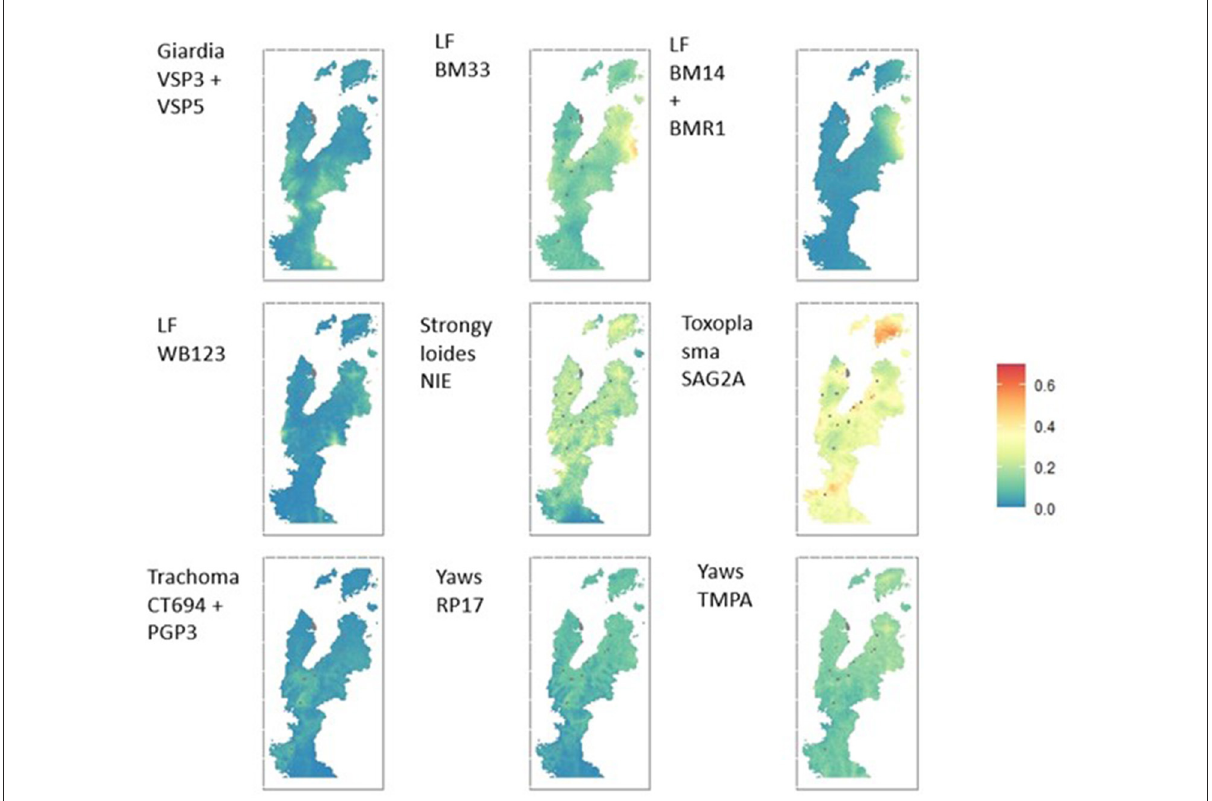
FIGURE3 Geostatistical maps showing mean posterior estimated seroprevalence per